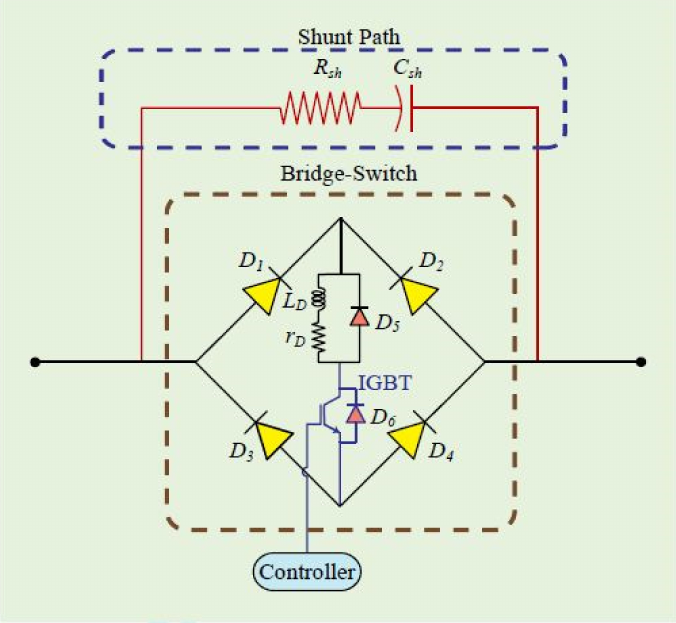
Figure 12. Control structure of CBFCL in DFIG and PMSG wind